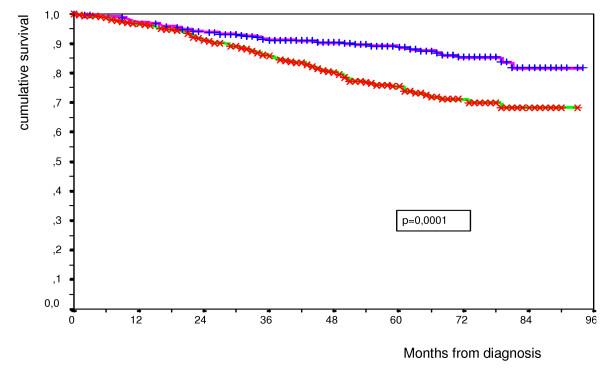
5-year event-free survival. 5-year event-free survival values between MSP participants and non-participants were equal to 89% and 75% respectively (Log Rank = 19.99). [ = MSP participants;  = MSP non-participants]